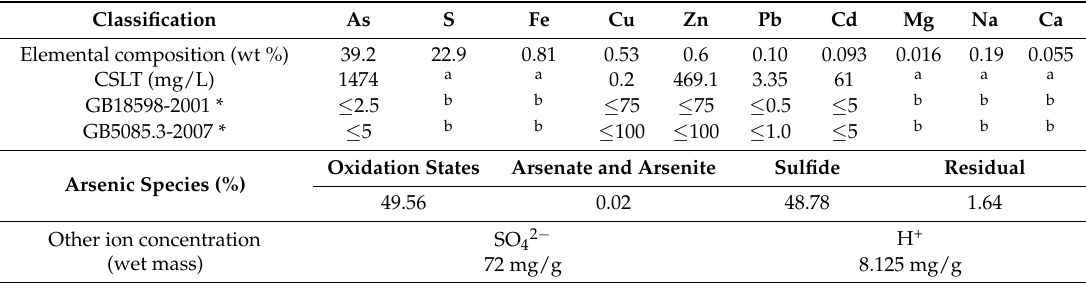
Table 2. Main elemental composition and leaching concentration of the raw ASS.